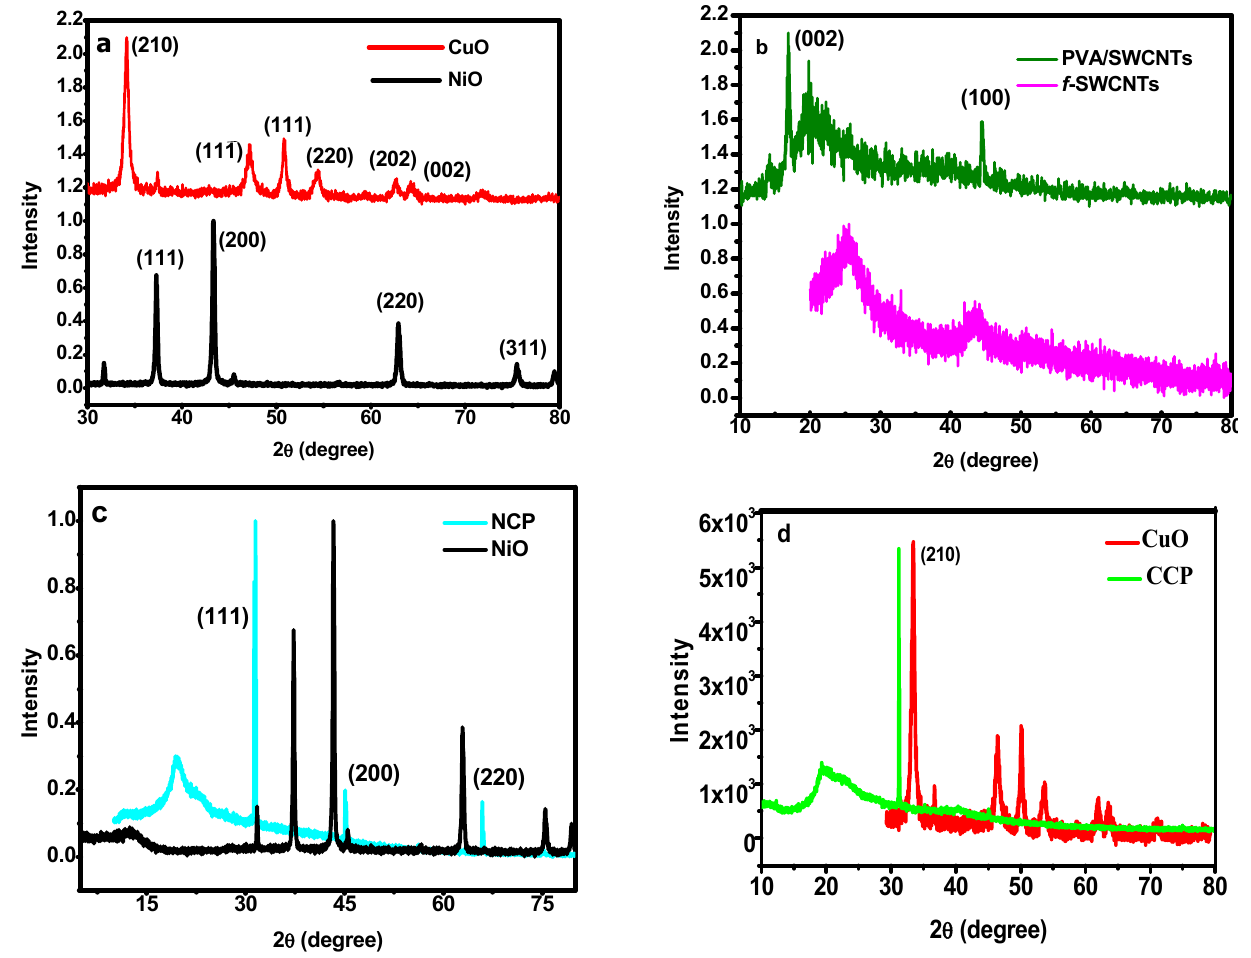
Figure 2. XRD patterns of: ( a ) CuO and NiO; ( b ) pure f -SWCNTs and PVA/SWCNTs; ( c ) NiO and NCP3; ( d ) CuO and CCP3.